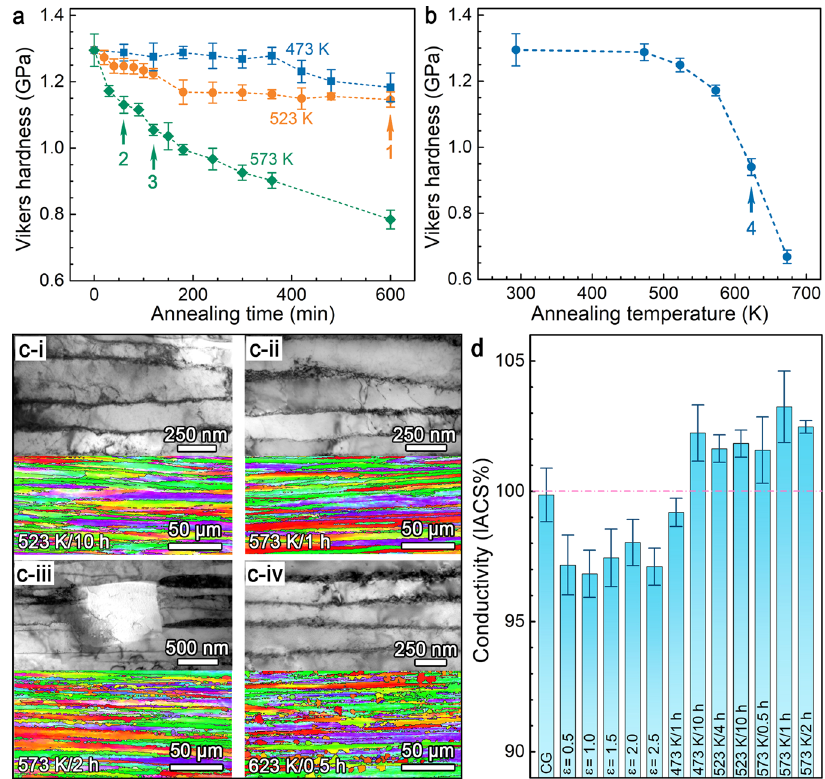
Fig. 5 Micro-hardness, microstructural evolutions and conductivity of the swaged copper with ε = 2.5 in the rod center during isothermal and isochronal annealing process. a Isothermal annealing at 473, 523, and 573 K (the error bar represents the standard deviation of hardness). b Isochronal annealing for 30 min at temperatures from 300 to 673 K (the error bar represents the standard deviation of hardness). c EBSD and TEM images of annealed side-view structure. d Conductivity of CG, swaged and annealed copper (the error bar represents the standard deviation of conductivity).